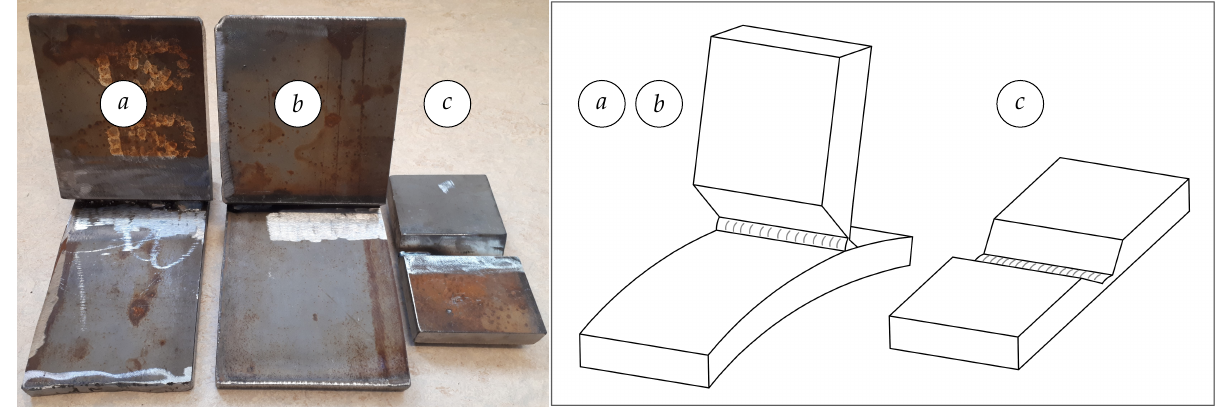
Figure 2. Three test objects used in the tests. The objects ( a ) and ( b ) represent a typical stub–joint groove, while the object ( c ) represents a typical butt-joint groove. The objects are welded with root welds of different widths. Schematic arrangement of the plates and the weld root pass in the test objects is shown to the right.